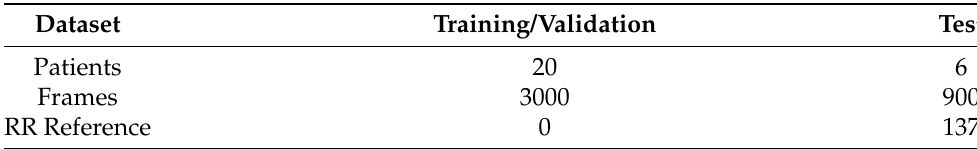
Table 1. Dataset division for training and validation of YOLOv4.